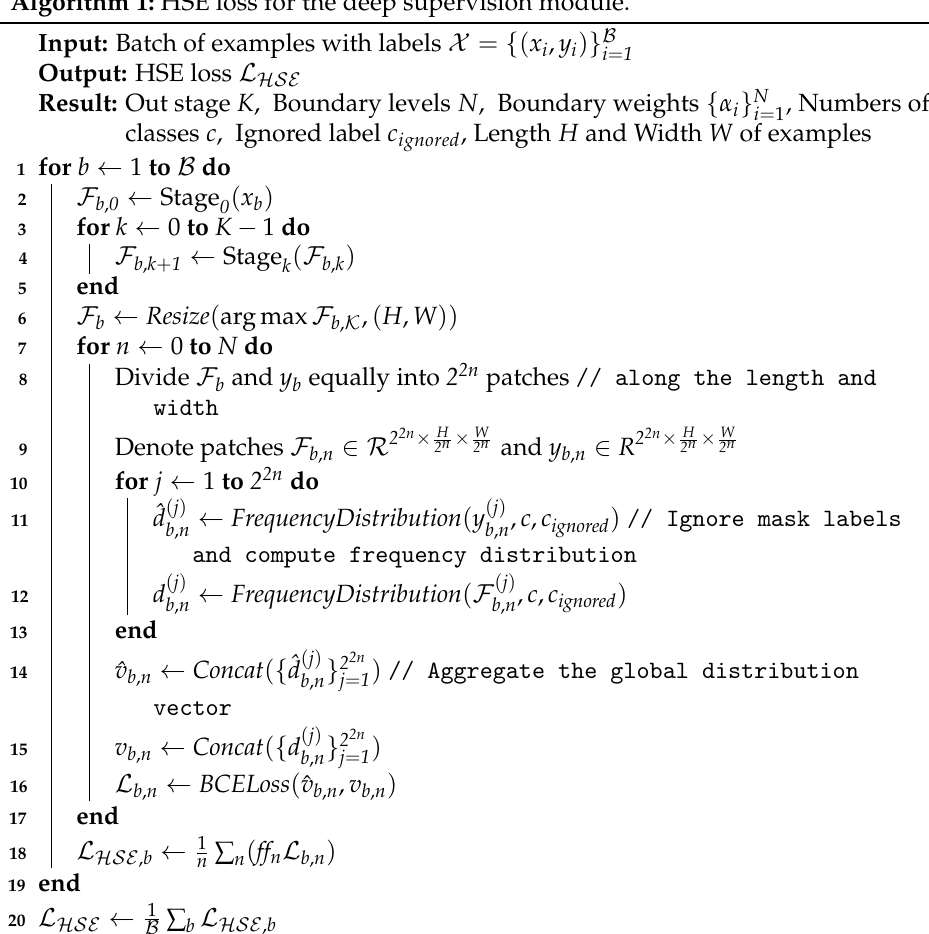
Algorithm 1: HSE loss for the deep supervision